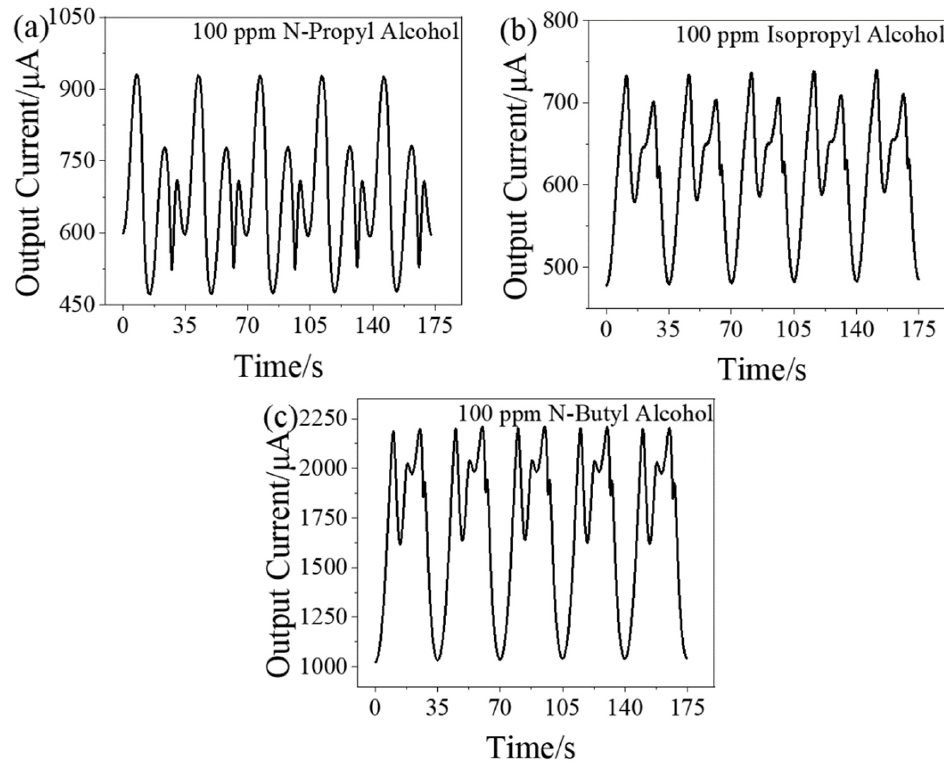
Figure 9. The dynamic response signal curves based on TW-3 ( a ) n-propyl alcohol ( b ) isopropyl alcohol ( c ) n-butyl alcohol.